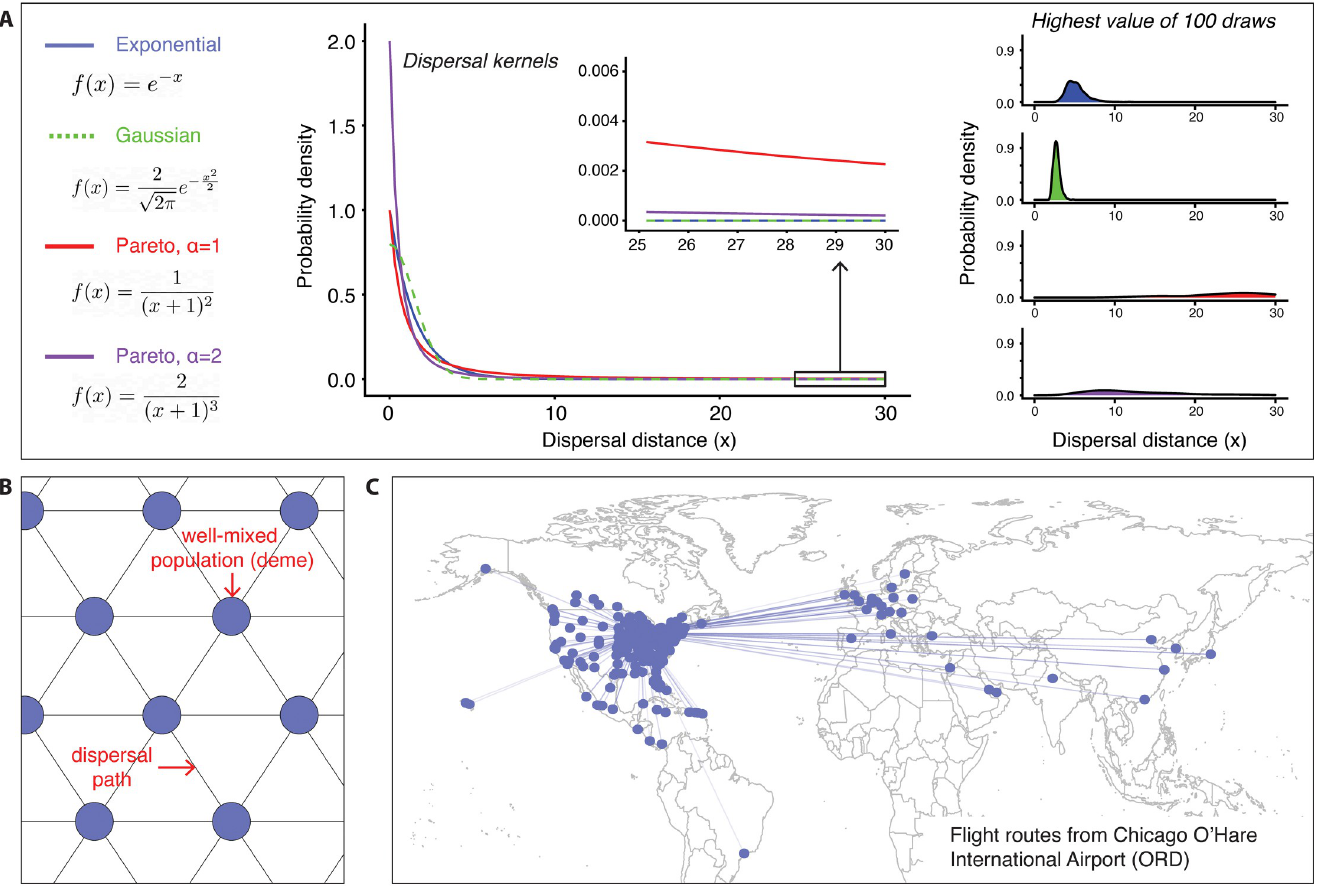
Fig 1. (A) Negative exponentially bounded vs. fat-tailed dispersal kernels. (Left) Four example dispersal kernels: exponential, folded Gaussian, and Pareto distributions. The Pareto distribution is a form of power-law distribution, which is a classic example of a “fat-tailed” distribution. (Middle) Probability density of each dispersal kernel, with the inset showing values in the tail. (Right) Density plots obtained from the set of highest values of 100 draws for each dispersal kernel. (B) Nearest-neighbor stepping stone model of migration. (C) Example of non-nearest-neighbor migration in the form of commercial flight routes originating from O’Hare International Airport in Chicago, Illinois. Dots represent airport locations. Constructed using publicly available data from https://openflights.org/data.html and Natural Earth using the R package ggmap [9].